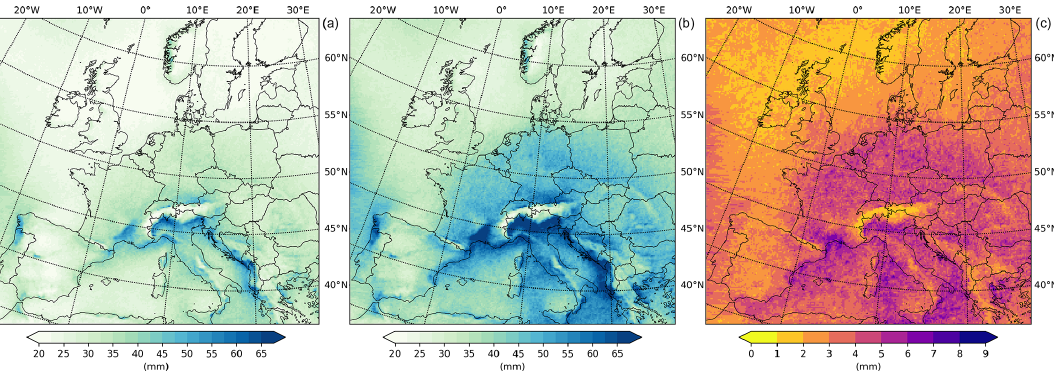
Figure 5. The 5% quantile (a) , 95% quantile, (b) and standard deviation (c) of the 50 CRCM5-LE members for 10-year return levels of 3h precipitation over Europe.